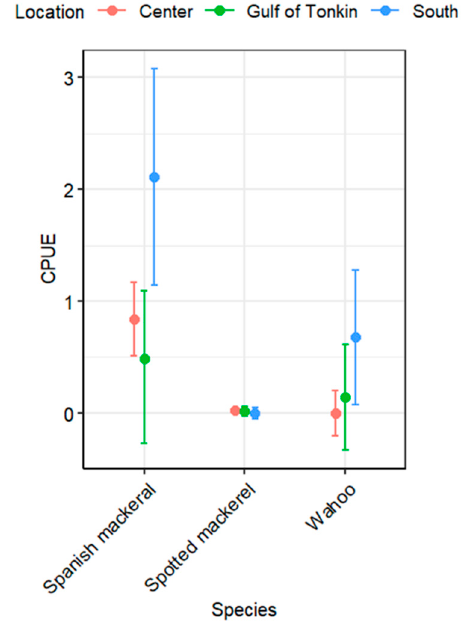
Figure 4. Mean CPUE (number of fish caught per h for webbing) of narrow-barred Spanish mackerel, spotted mackerel, and wahoo caught in the Gulf of Tonkin (green), center (red), and south (blue) of Vietnam. Points represent mean catch. Bars are 95% confidence intervals. Negative confidence intervals indicate that they are not statistically signi fi cant.